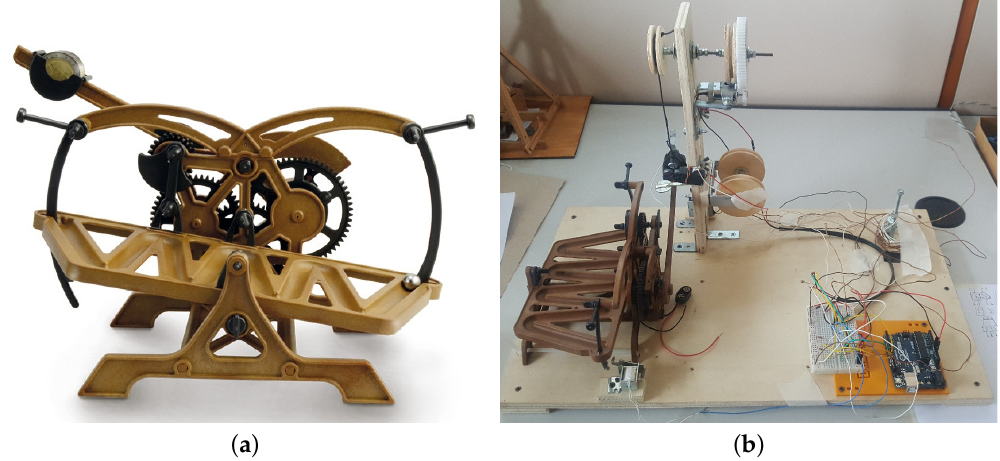
Figure 4. Machine 4, the Rolling Ball Timer: realized model ( a ); automated Leonardo rolling ball timer ( b